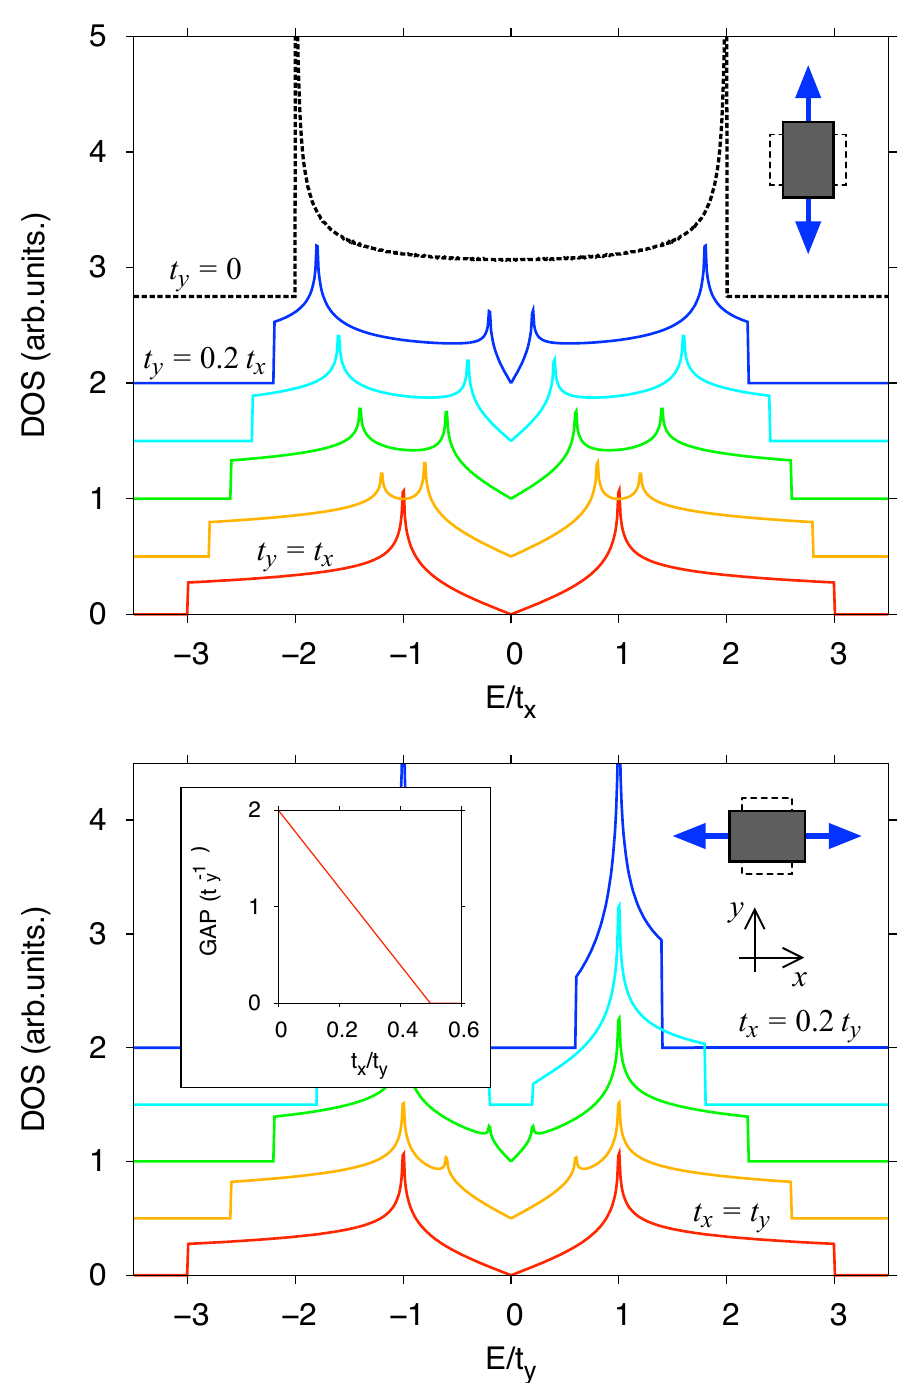
Figure 2. Density of states for the Hamiltonian (1) with U = 0 displayed as a function of energy. Top: strain applied in the armchair direction ( t y (cid:54) t x ). Bottom: strain applied in the zigzag direction ( t y (cid:62) t x ). The ratio t < / t > [with t < = min ( t x , t y ) and t > = max ( t x , t y ) ] is varied between the lines with the steps of 0.2. A vertical offset is applied to each dataset except from the isotropic case ( t x = t y ). Inset shows the band gap, appearing for t x < 0.5 t y due to the Peierls